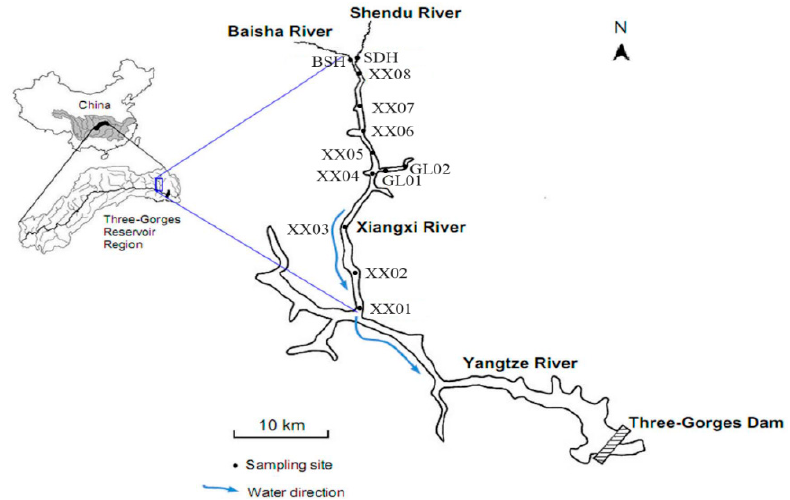
Figure 1. Sketch map of sampling stations in the Xiangxi River.